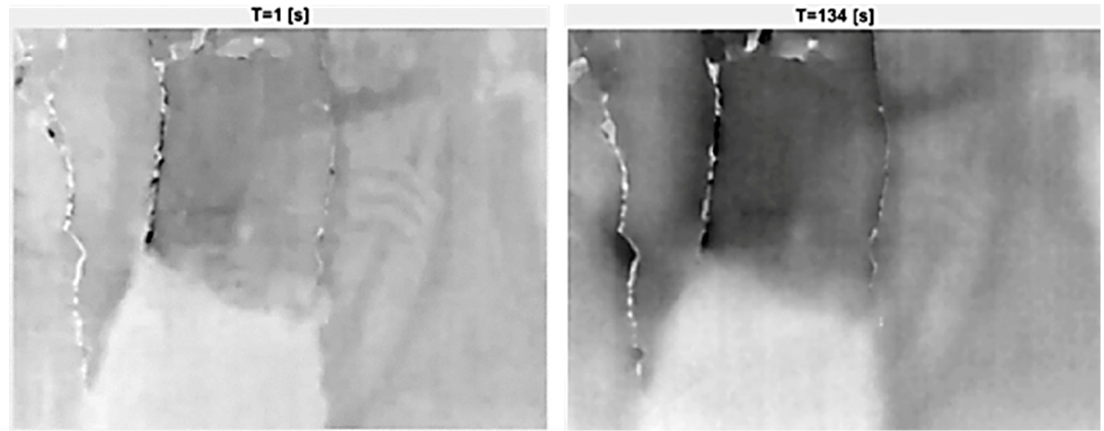
Figure 14. Emissivity images at 1 s and 134 s of a portion of the frieze obtained using PuCT before consolidation, showing deep cracking, detachment, and deformations.